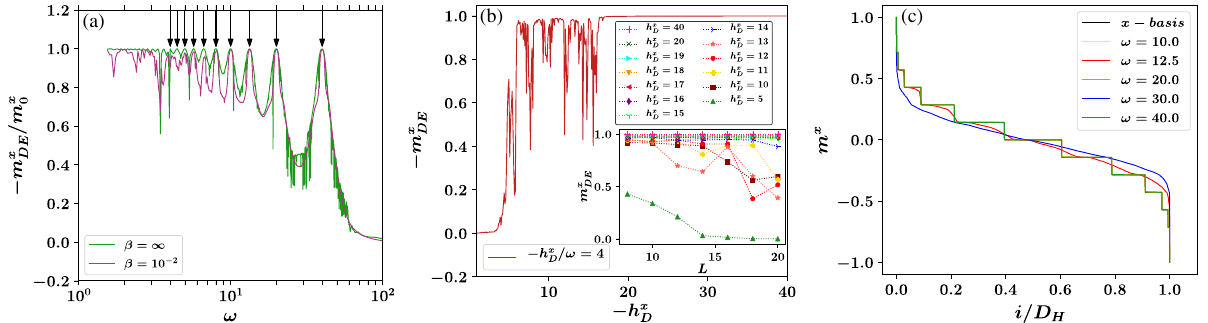
=m x FIG. 1. Scars, resonances, and emergent conservation law. (a) m x 0 , the ratio of magnetizations after infinite (diagonal ensemble DE average) and 0 (initial state) cycles versus drive frequency ω . Freezing, reflected in a large value of this ratio, occurs over a broad range of ω and is strongest at particular “ scar ” points (marked with arrows) h x D ¼ k ω , where k is an integer (for h x D ¼ − 40 here, the ten arrows mark ω ¼ 40 =k ; k ¼ 1 ; 2 ; … ; 10 ). Results are shown for zero and high-temperature initial states: the former being the ground state of H ð 0 Þ [which gives an initial magnetization m x ð 0 Þ ≲ 1 ], and the latter being the Gibbs state with β ¼ 10 − 2 [ m x ð 0 Þ ≈ 0 . 05 ] for H I of the form H ð 0 Þ but with h x D ¼ 5 ; all other parameters are the same as the driven Hamiltonian, namely, J ¼ 1 ; κ ¼ 0 . 7 π = 3 ; h x e= 10 ; h x 40 ; h z ¼ 1 . 2 ; L ¼ 14 . The sharp dips in the green lines represent resonances, discussed in detail in D ¼ 0 ¼ the main text on Floquet-Dyson perturbation theory. Parameters are chosen to avoid these resonances. (b) m x as a function of h x D for a fixed ratio j h x D = ω j ¼ 4 , showing the freezing cutoff ð h x D ≈ 18 Þ above which a stable regime of freezing sets in. Inset: finite-size behavior of the freezing. For intermediate strengths of the driving field, higher-order resonances lead to nonmonotonic behavior of m x on L , DE which is then sensitively dependent on small variations of h x D . (c) h m x i of the Floquet states plotted against the serial number (normalized by the Hilbert space dimension D H ) of the Floquet states, arranged in decreasing order of h m x i . At the scar points ( ω ¼ 10 , 20, and 40), the h m x i values form steps coinciding with the eigenvalues of m x arranged and plotted in the same order: m x emerges as a emergent conserved quantity, hence the freezing of m x for any generic initial